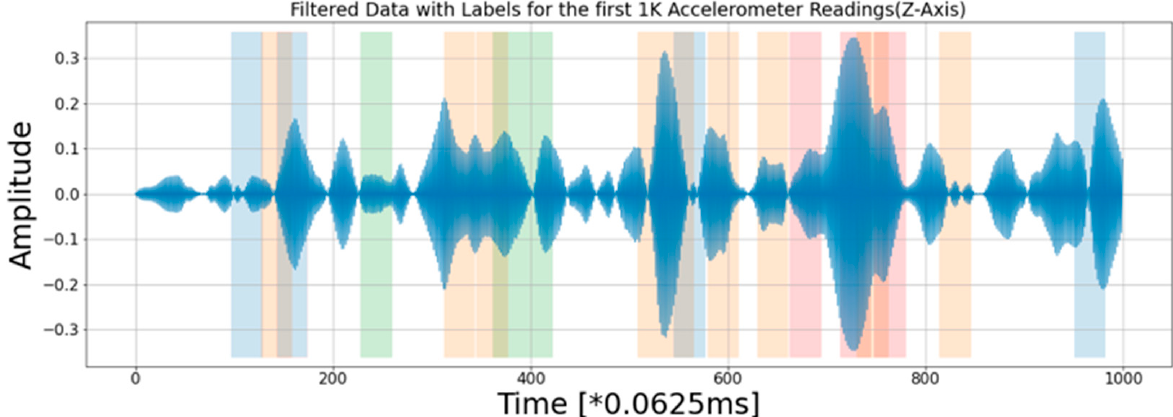
Figure 5. Filtered signal with labels.